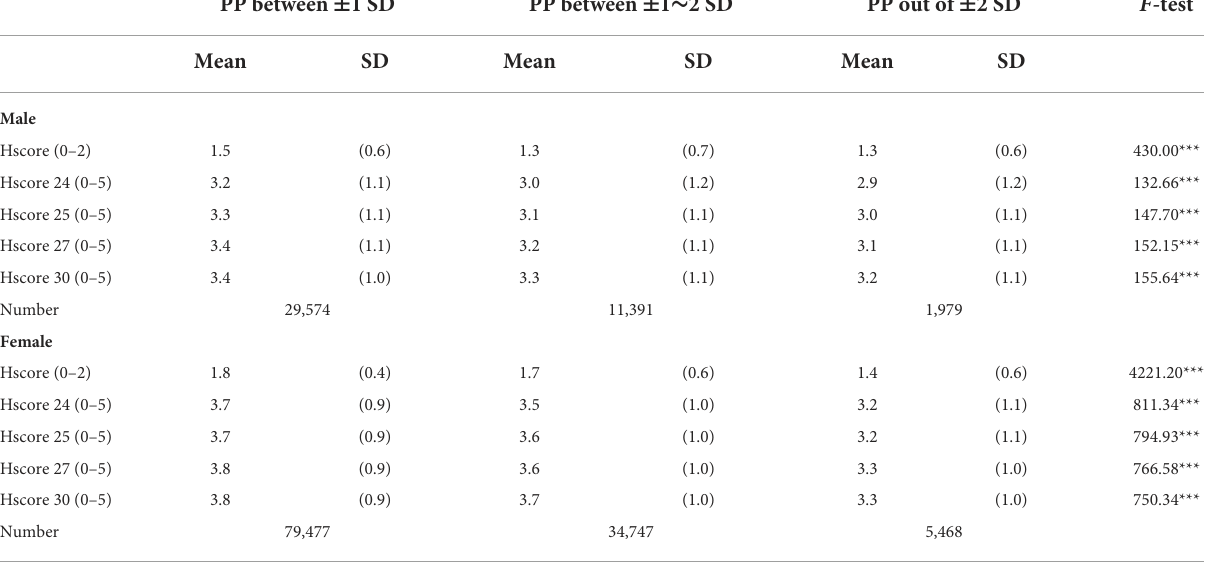
TABLE 4 Health score (Hscore) significantly correlates with pulse pressure